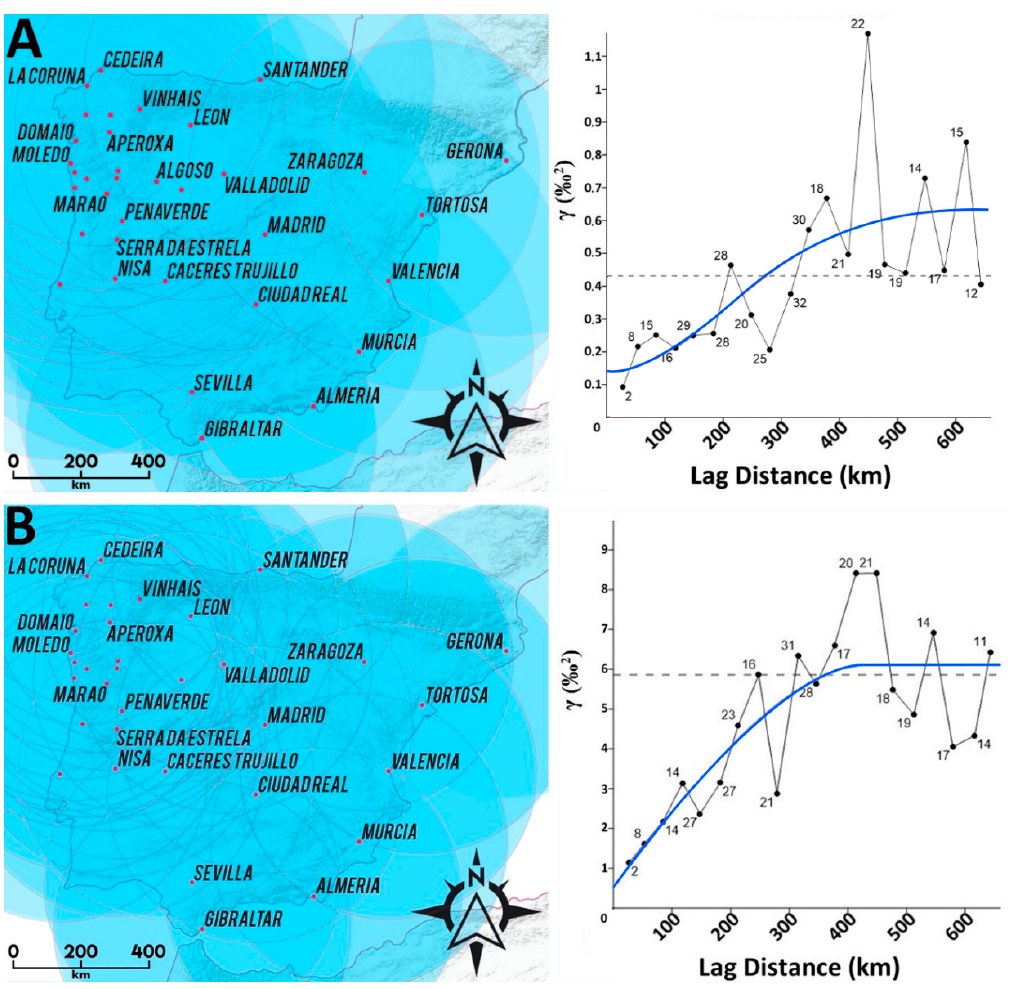
Figure 5. Maps representing the sampling sites (left panels: red dots), the range ellipses around them (blue circles) and the empirical (black line with dots in right panels) and fitted theoretical semivariogram (continuous lines in right panels) derived from δ 18 O p ( A ) and d-excess ( B ). For δ 18 O p ( A ) the parameters of the Gaussian semivariogram model fitted were C 0 = 0.135; C 0 + C = 0.635; a e = 507 km; r 2 = 0.49; RSS = 0.644. For d-excess ( B ) the parameters of the spherical semivariogram were C 0 = 0.51; C 0 + C = 6.105; a = 439 km; r 2 = 0.66; RSS = 29.7. The bin width was 33 km; the dashed horizontal line represents the variance. The figure represents the period October 2004–July 2006.